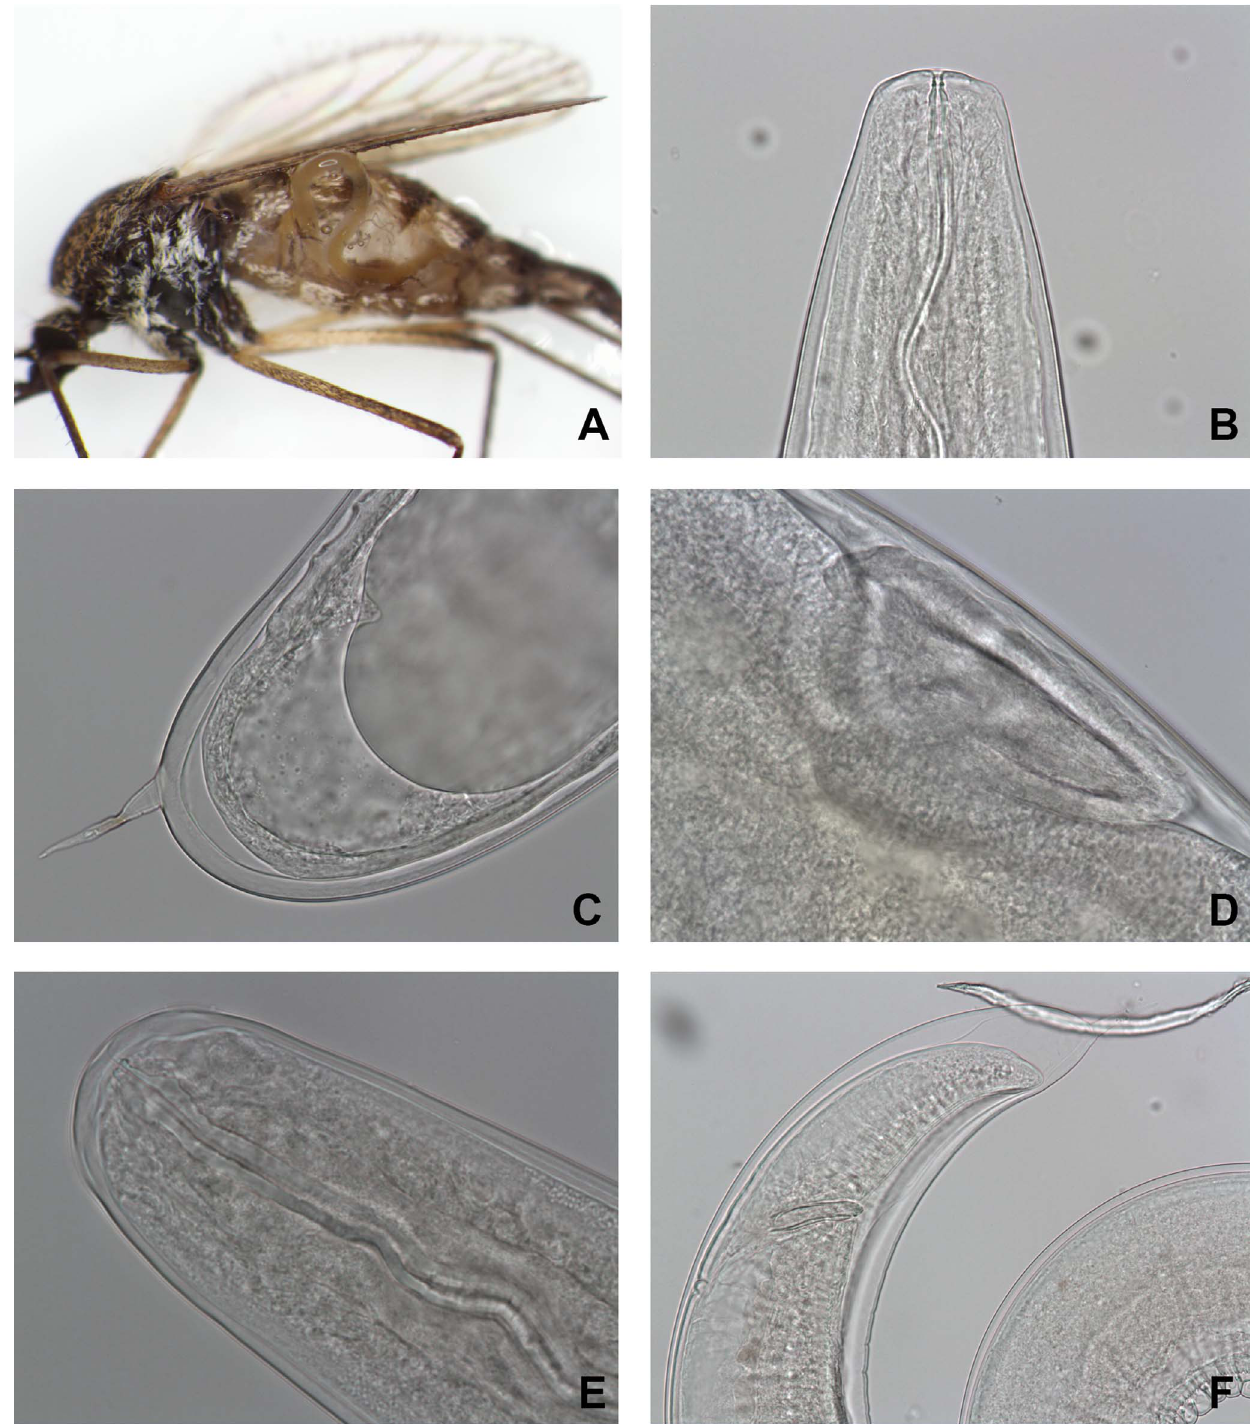
Figure 1. Aedes rusticus parasitized by a mermithid (A) and microphotographs of mermithid specimens isolated from Ae. rusticus . B, E: head; C, F: tail showing details, exhibiting a spur; D: